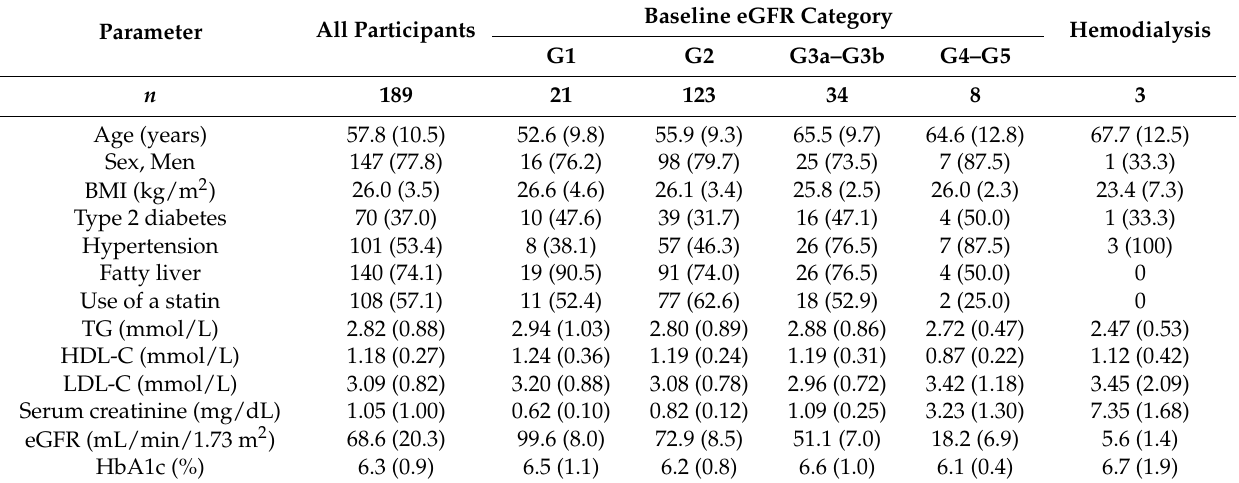
Table 1. Characteristics of patients at